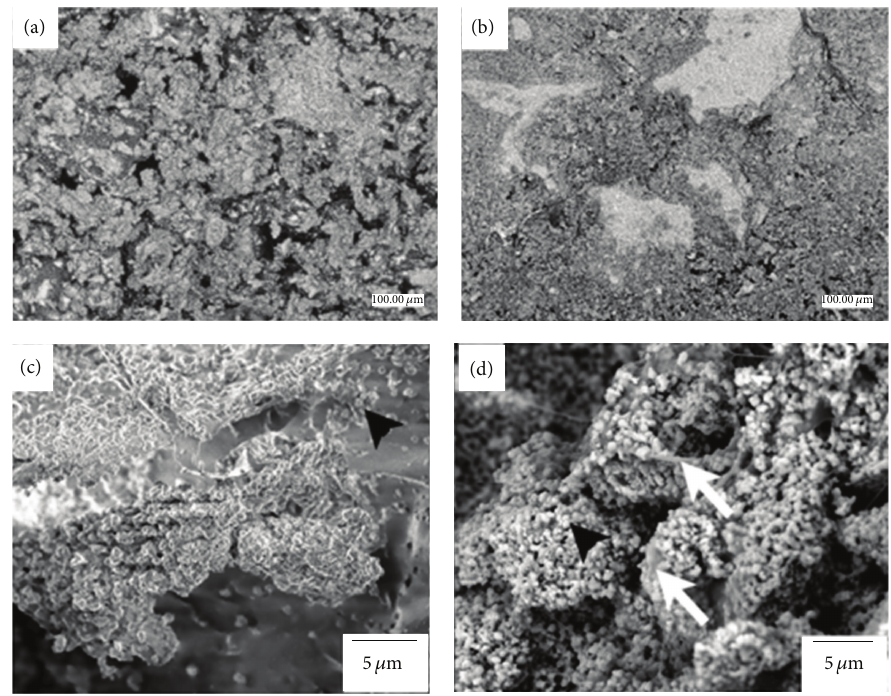
Figure 1: While the macrogeometric structure of both bone blocks were similar. At low magnification, scanning electron micrographs of the difference in HA particle size was easily depicted between (a) control and (b) experimental blocks. Field-emission scanning electron micrographs of the experimental group depicted the (c) nanoHA particles within the biopolymeric matrix (arrowheads) and that (d) collagen infusion took place at the nanometer scale (arrows).